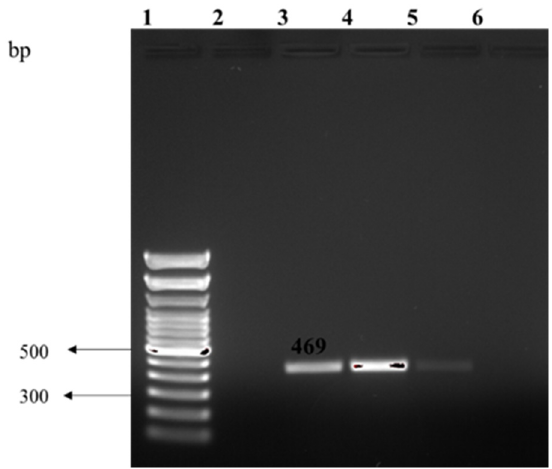
Figure 2. Represents PCR amplification of the omp A gene in Cronobacter sakazakii, Lane 1: 1 kb